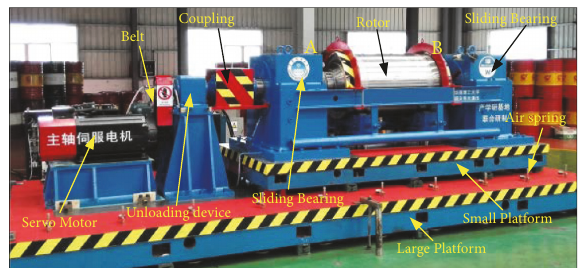
Figure 7: Large rot or vibration test bed.